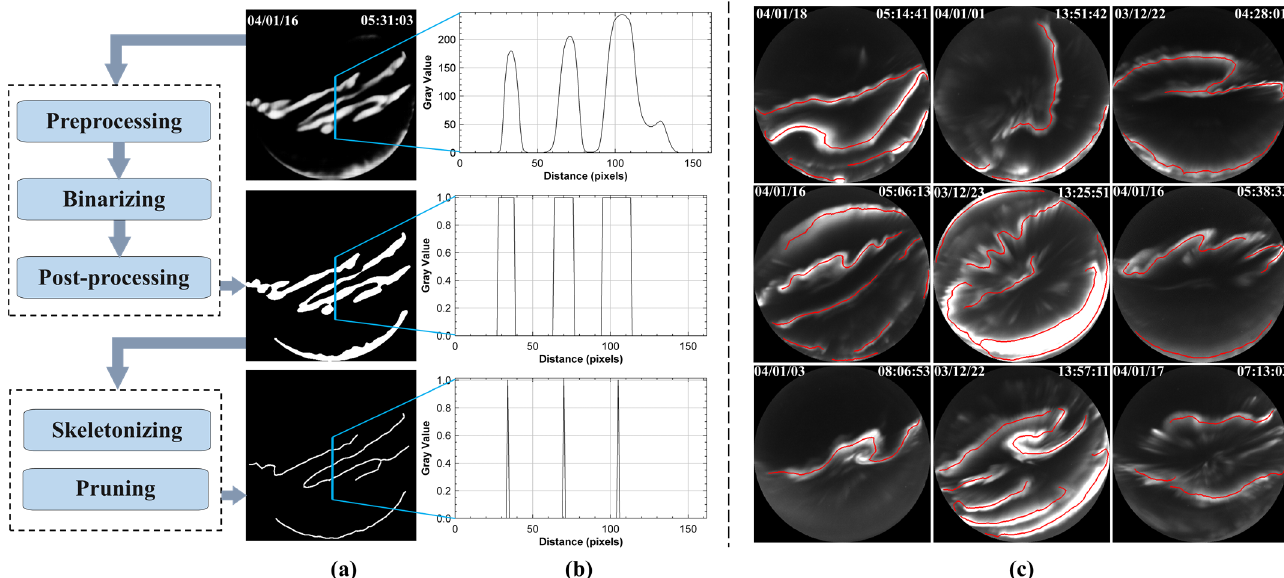
Figure 3. Extraction of auroral skeletons. ( a ) The skeletons of auroral arcs are obtained from ASI images. ( b ) The profiles along the blue lines shown in ( a ). ( c ) Some examples of extracted auroral skeletons in ASI images.